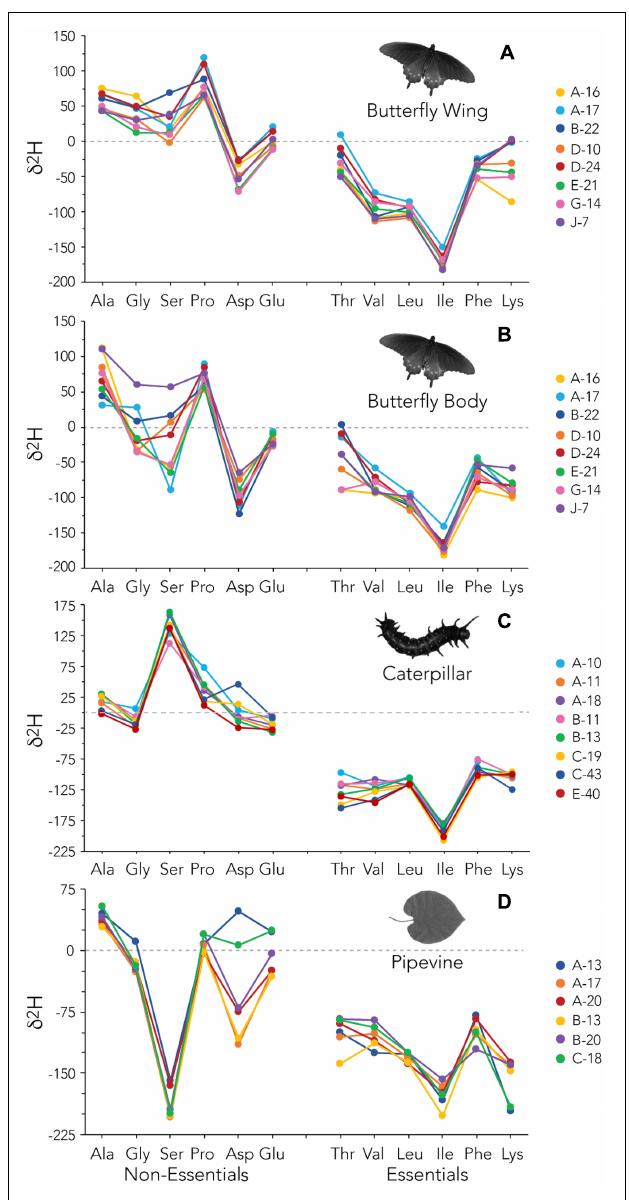
FIGURE 4 | Amino acid δ 2 H data for individual butterfly wings (A) , butterfly bodies (B) , caterpillars (C) , and pipevine leaves (D)